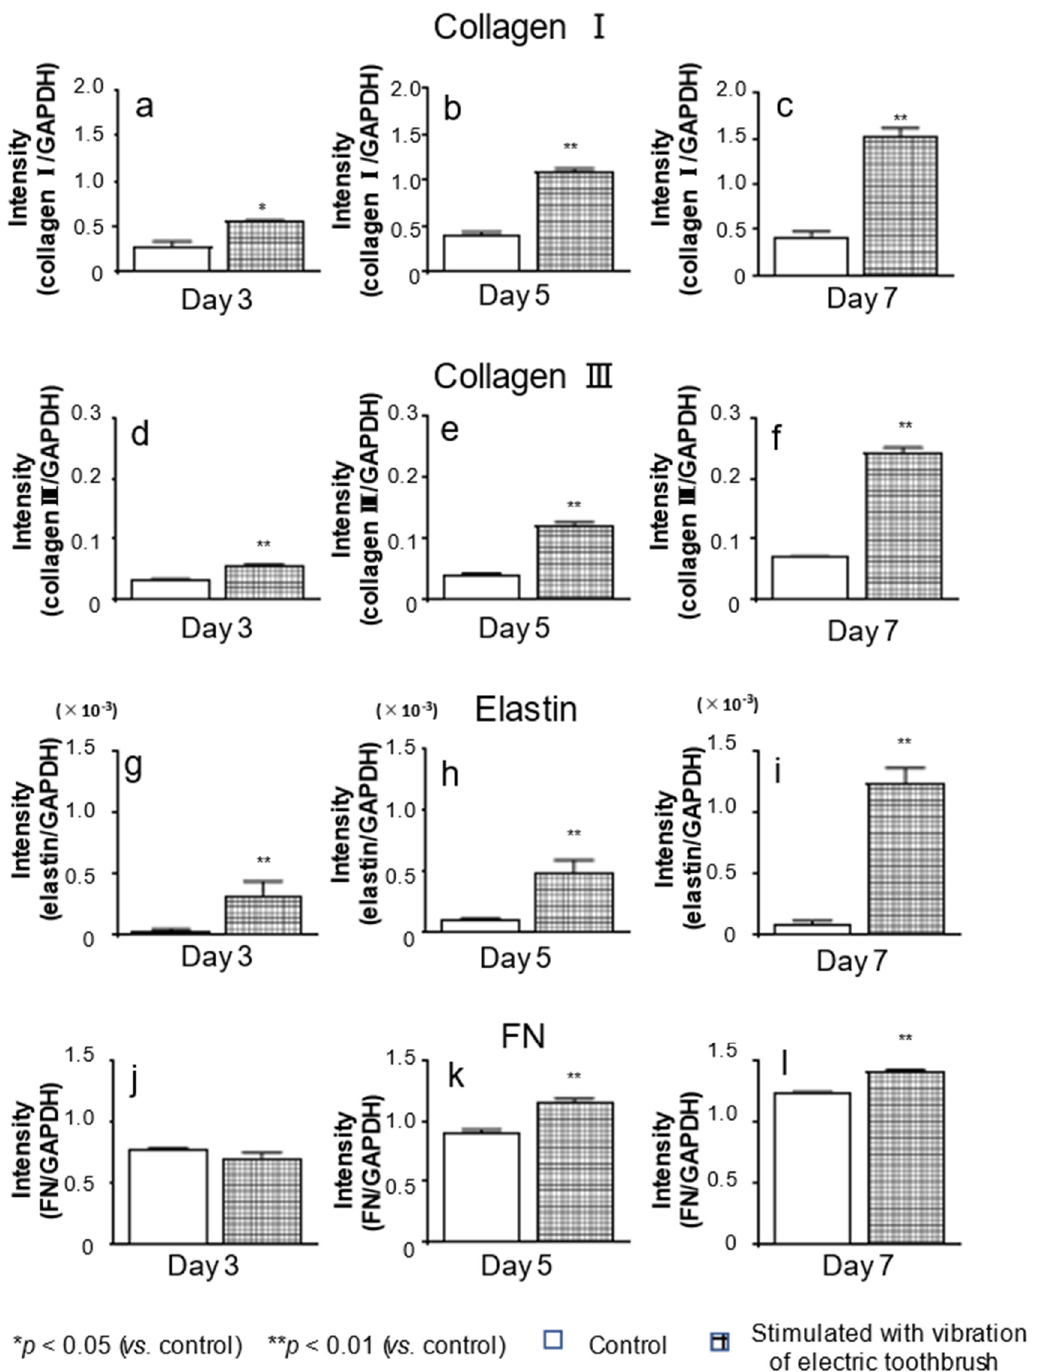
Figure 2. Effects of exposure to vibratory stimulation with an electric toothbrush on the mRNA expression of ECM factors in gingival fibroblasts. HGnFs were exposed to vibratory stimulation with an electric toothbrush for 7 days. The mRNA expression of ECM factors ( a – l ) was quantified using real-time PCR. Each bar indicates mean ± standard deviation (SD) of five independent experiments. * p < 0.05, ** p < 0.01 (vs. control).